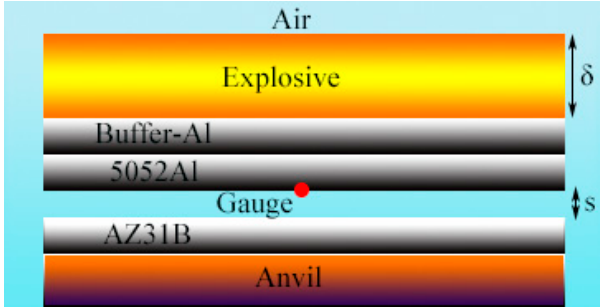
Figure 1. Diagram of numerical simulation arrangements.